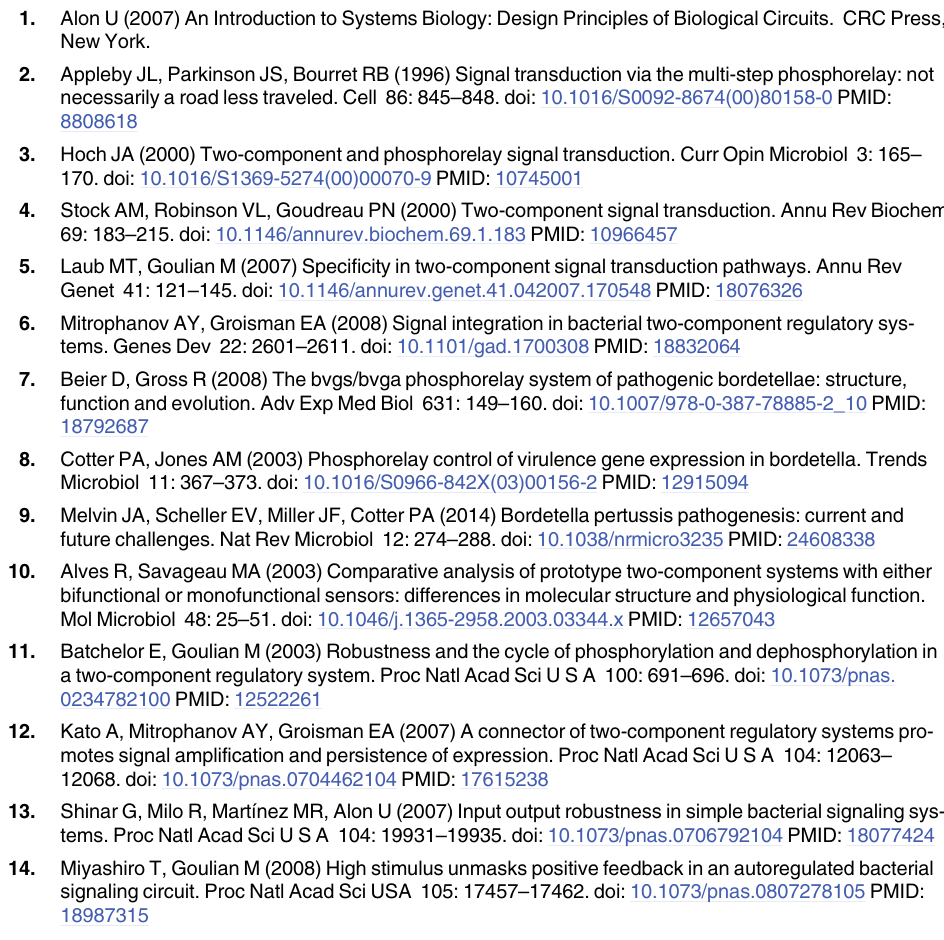
Table 1. Note the logarithmic scale in the ordinates. S1 Table. CC, RCC, and PRCC values for all the input parameters with output β for k ps = 10 − 2 at different range of